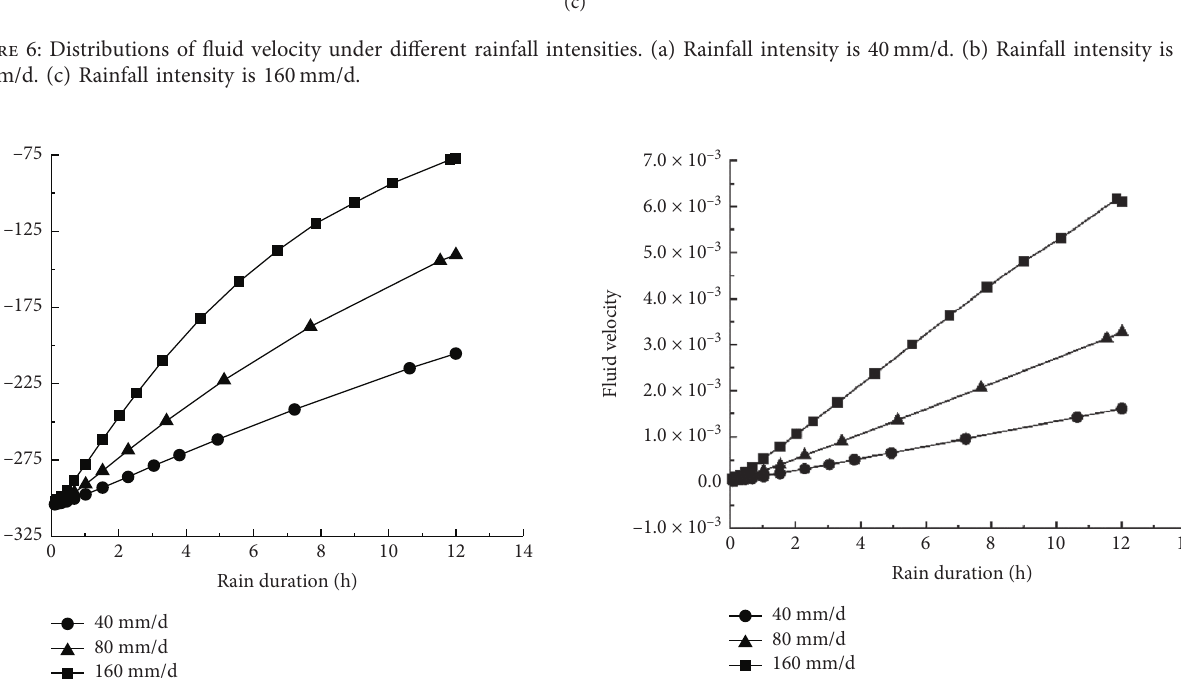
Figure 7: Curves of pore pressure-rain duration at point A under different rainfall intensities.